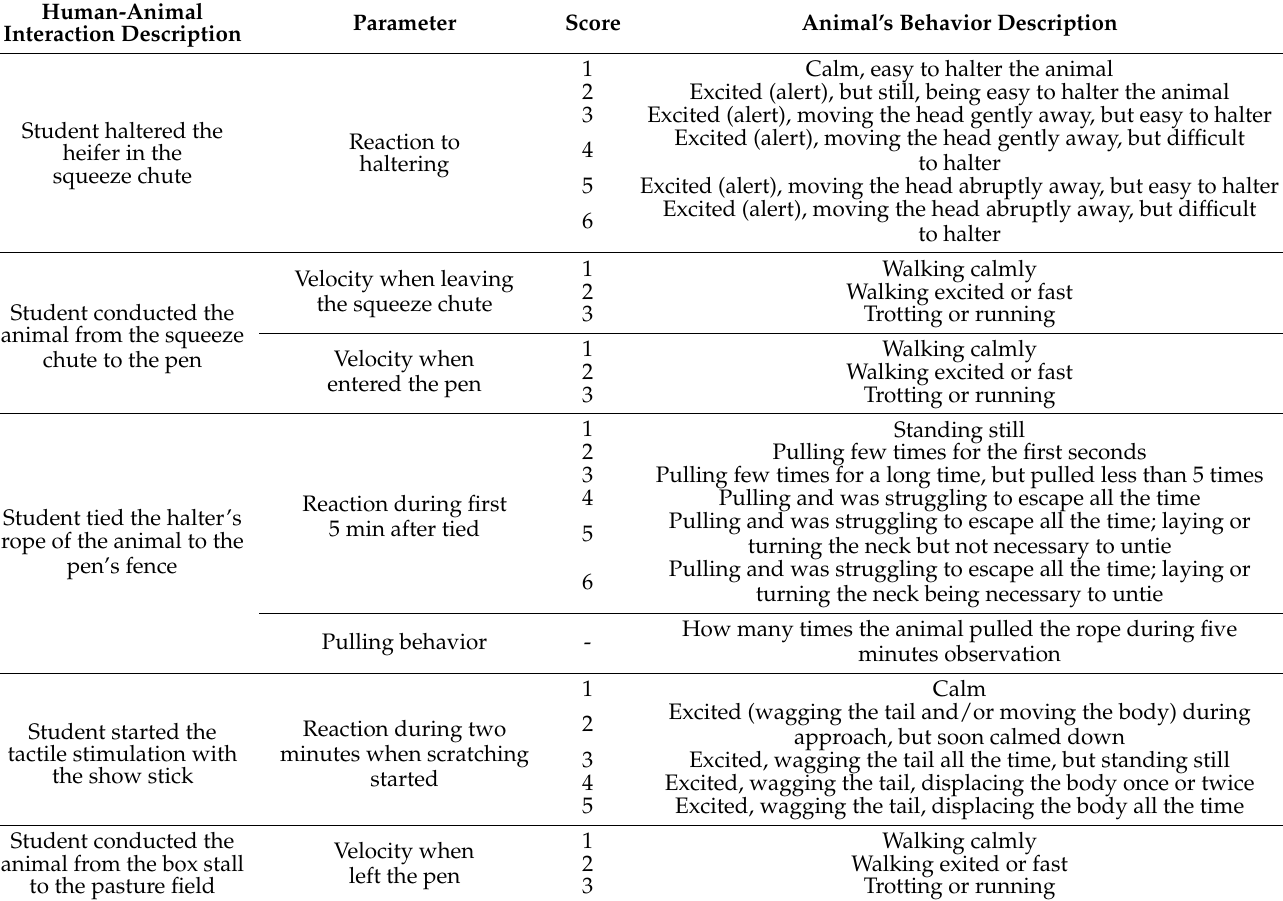
Table 2. Behavioral measurements of the animals during the human-animal interaction in handling on the first day of halter breaking habituation.